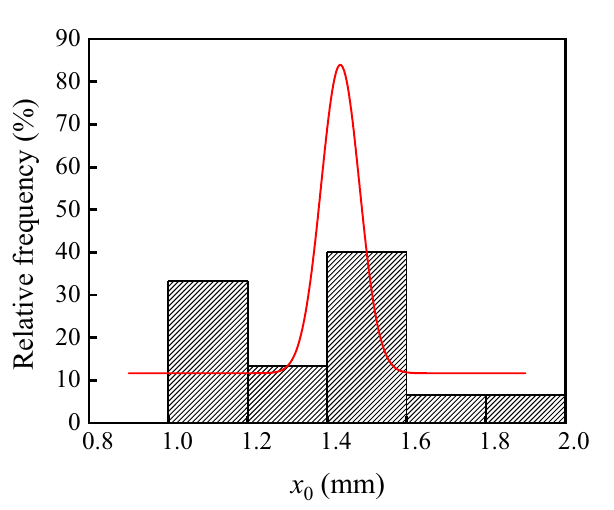
Figure 13. Frequency distribution histogram of x 0